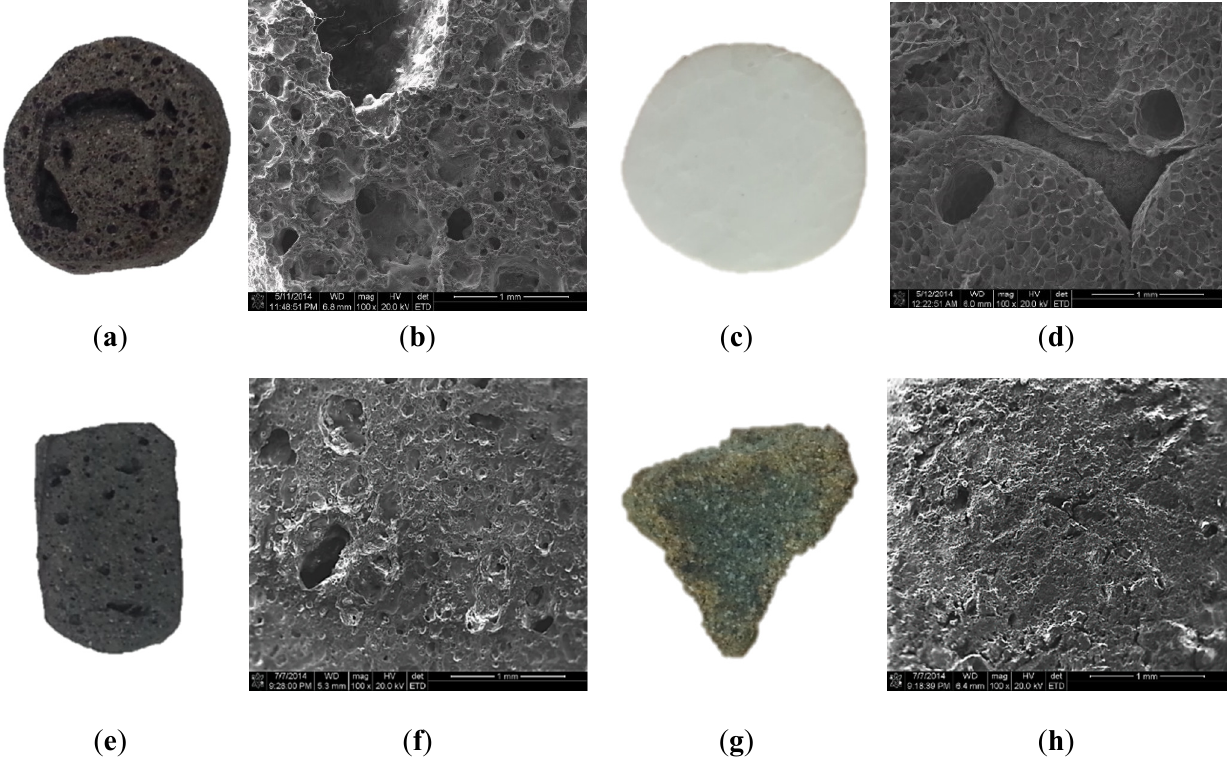
Figure 4. Cross section of lightweight aggregates and its microscopy image: ( a , b )